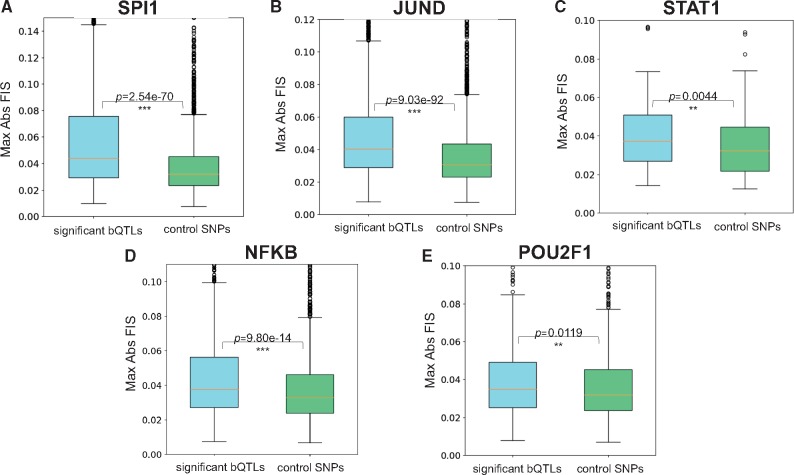
Distribution of maximal absolute feature interaction scores (FIS) for TF bQTLs and control SNPs for SPI1 (A), JUND (B), STAT1 (C), NFKB (D) and POU2F1 (E). bQTLs of all TFs exhibit significantly stronger max FIS compared to control SNPs